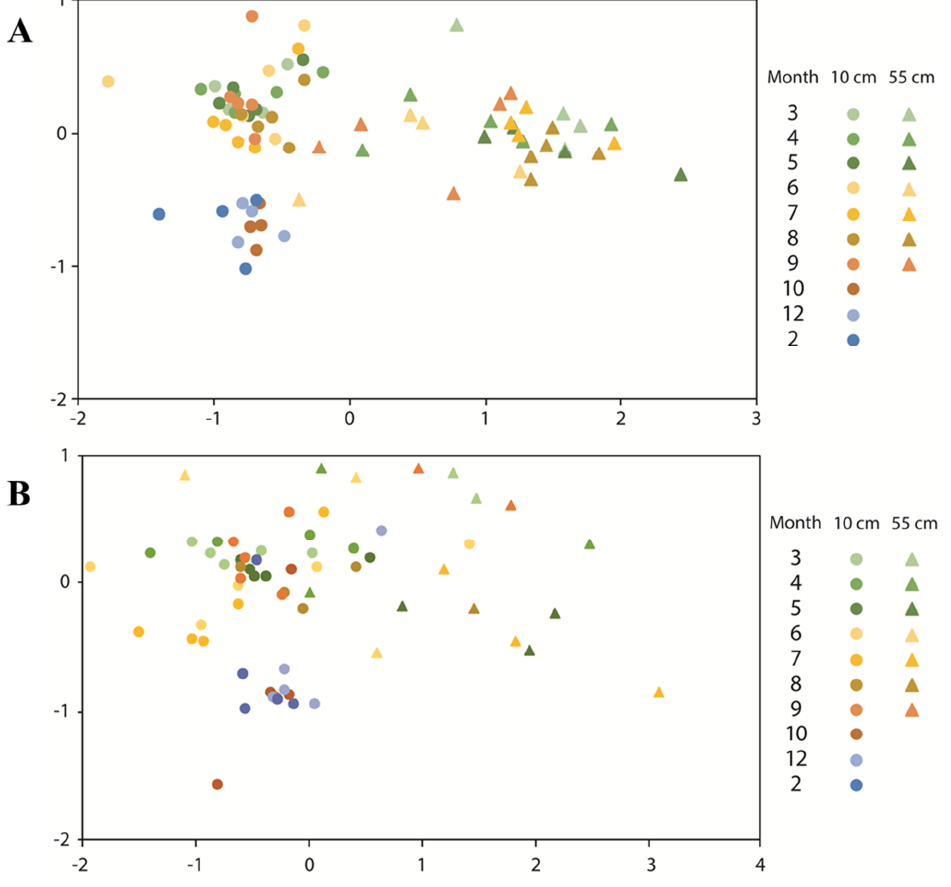
Figure 6. Non-metric multidimensional scaling plots of total ( A ) and active ( B ) soil bacterial com- munity patterns in different sampling times using UniFrac (10 cm is the sampling depth for upper organic horizon, 55 cm is the sampling depth for lower mineral horizon).